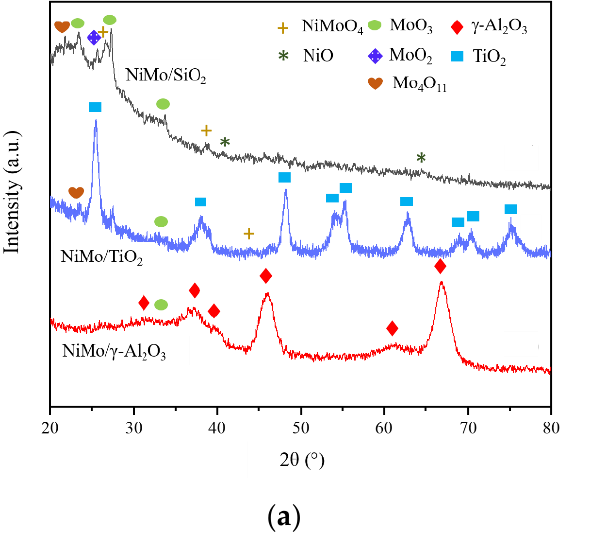
Figure 1. The adsorption–desorption isotherms of the calcined NiMo/ γ -Al 2 O 3 , NiMo/SiO 2, and NiMo/TiO 2 catalysts.